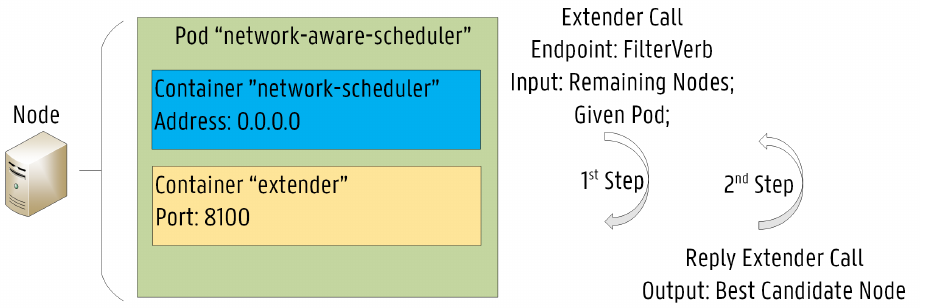
Figure 5. The detailed Pod architecture of the Network-Aware Scheduler